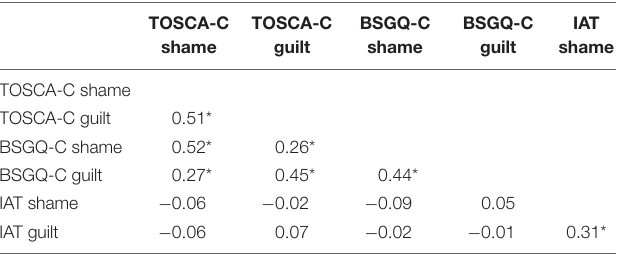
TABLE 2 | Correlations (controlled for gender and age) between explicit and implicit measures of self-conscious emotions as completed by the children ( N =